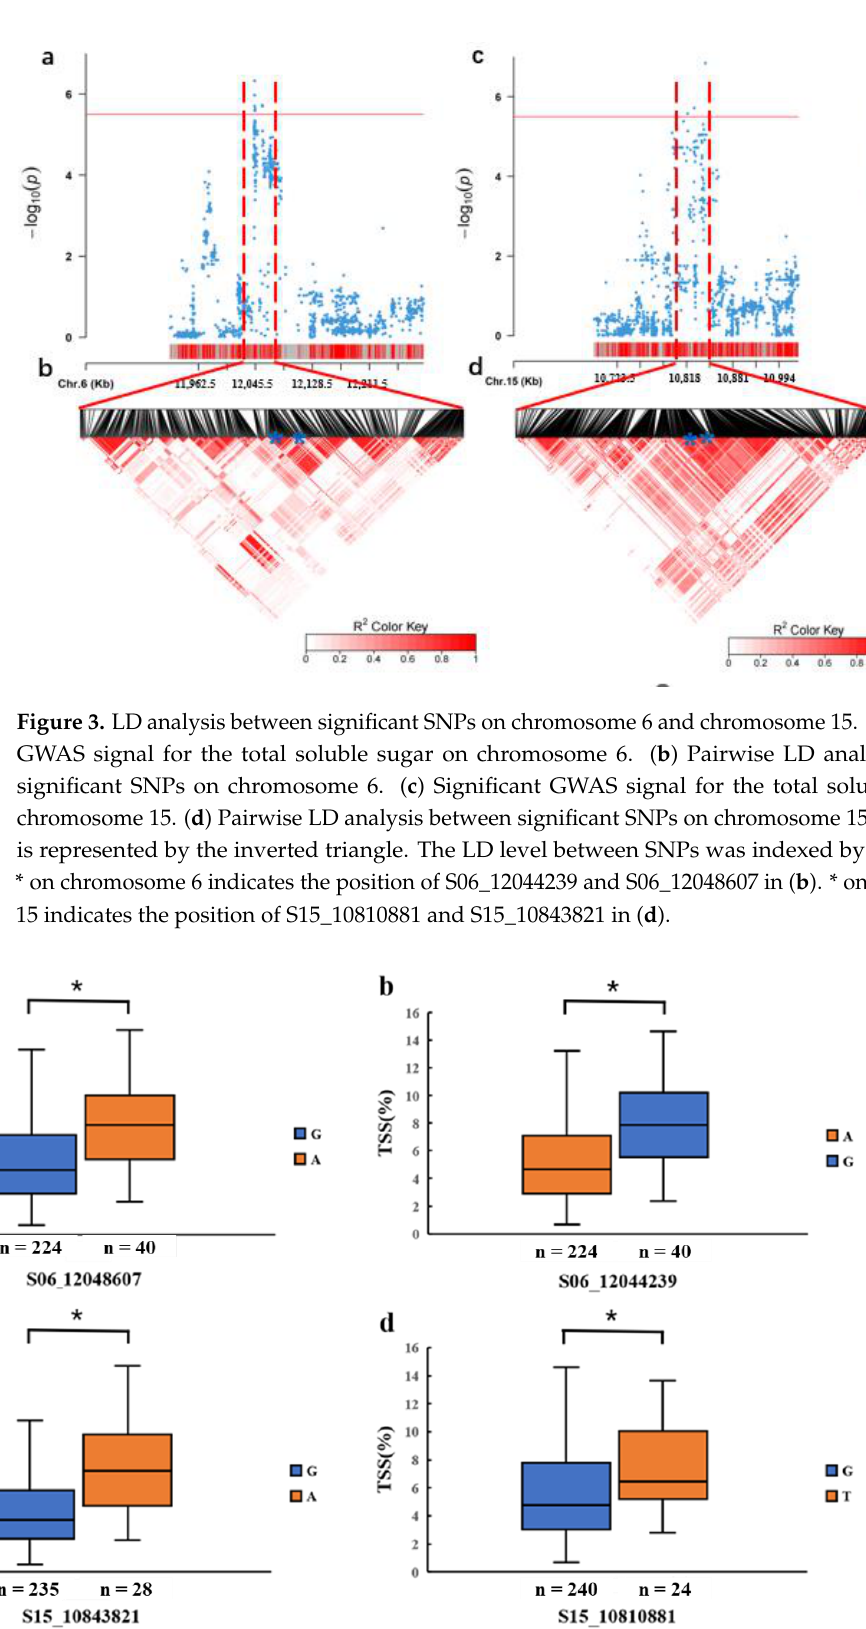
We found that the peak SNPs S15_10810881 and S15_10843821 were located 30 kb apart from each other, while S06_12044239 and S06_12048607 distanced 50 kb from each other (Table 1). According to gene annotation, we identified 26 and 25 candidate genes near these regions on Chr.06 and Chr.15, respectively (Table S2; Table S3). To confirm which genes are associated with fresh seed soluble sugar, we performed a RT-PCR analy- sis to investigate the expression of these genes in soybean accessions that differed signifi- cantly in total soluble sugar (NPS004 and NPS251 with low TSS content, NPS040 and NPS096 with high TSS content). The results demonstrated that the expression of 10 genes on Chr.06 and 12 genes on Chr.15 were below the detection level, while 18 genes did not change significantly (Figure 5). However, seven (on Chr.06) and four (on Chr.15) genes showed a significant difference at R6 stage in soybean accessions (Figure 5). Based on the expression levels in soybean accessions with significantly different total soluble sugar, we found